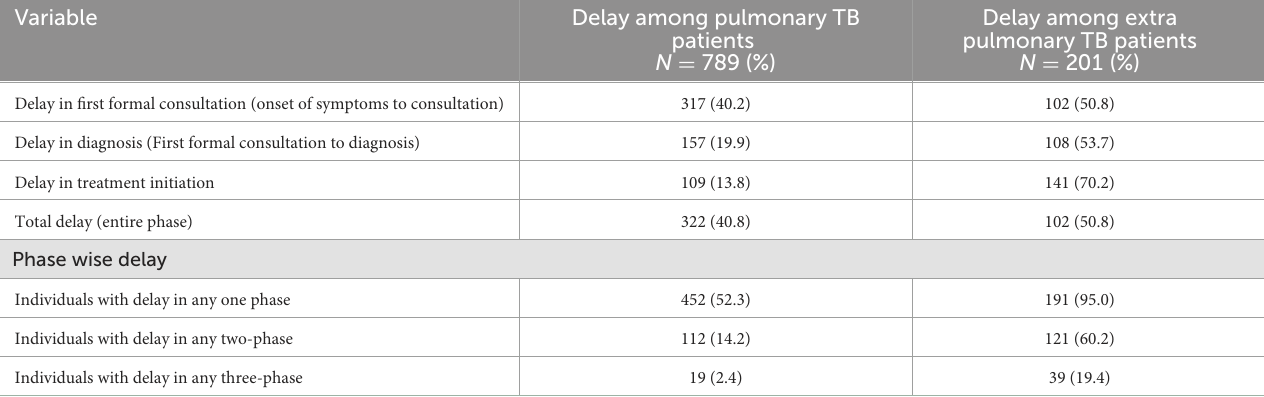
TABLE 3 Delay at the various phase of the care cascade among surveyed TB patients in two Indian states Jharkhand, Gujarat during Jan–Jul 2021. Variable Delay among pulmonary TB